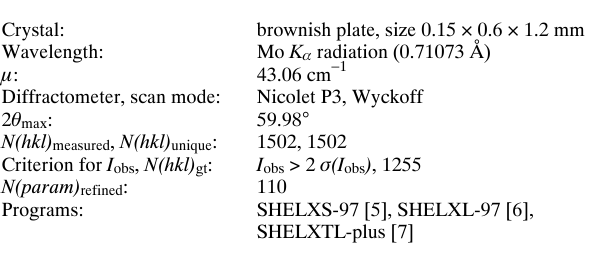
Table 1. D a t a collection a nd h a ndling.